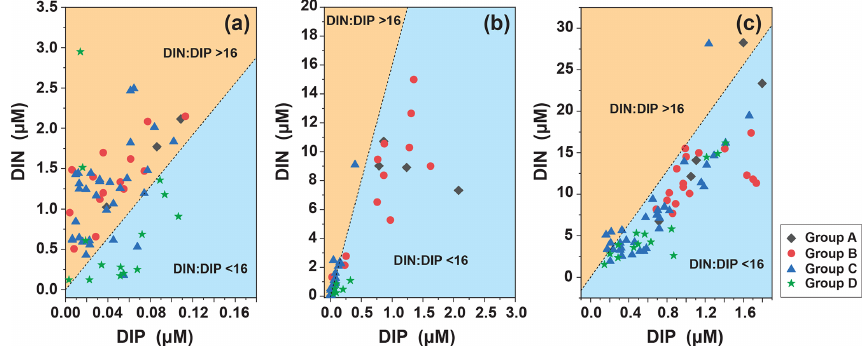
Figure 11. Distribution of phytoplankton community in DIN and DIP (a) at 5m, (b) the SCM layer, and (b) at 200m. The dashed line indicates the Redfield ratio of N:P = 16:1. Table 3. Historical data of the phytoplankton community in the WPO. Month Sampling